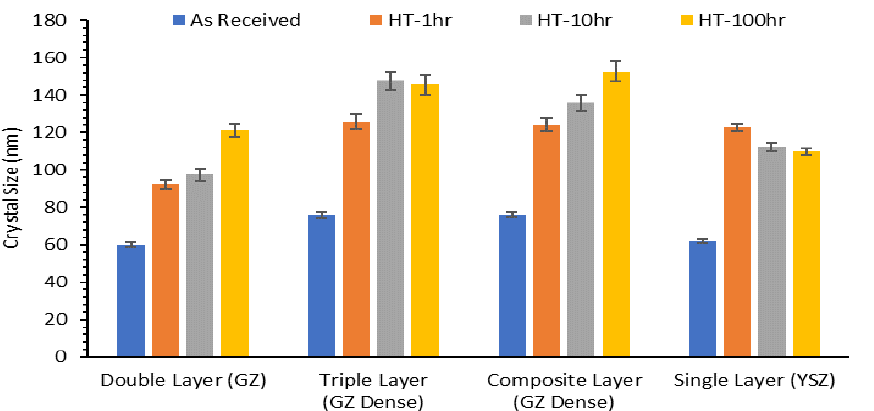
Figure 8. Crystallite sizes evolution of the investigated TBC systems (as-sprayed and heat-treated) obtained by Rietveld Refinement of the XRD patterns.